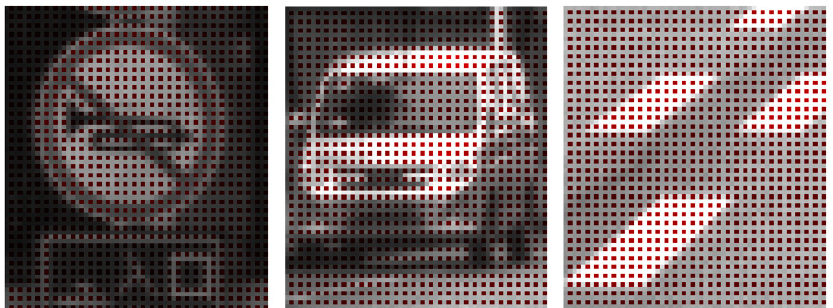
Figure 3. Three sample parts of source RCCC image.